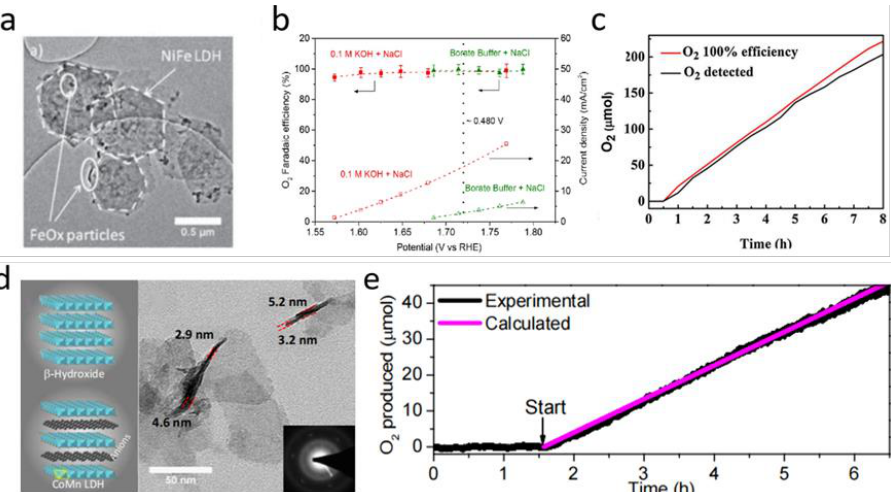
Figure 3. ( a ) TEM image of NiFe LDH nanoparticles [42]. ( b ) O 2 Faradaic efficiency of NiFe LDH nanoparticles in 0.1 M HClO 4 + 3.5 wt% NaCl [42]. ( c ) Faradaic efficiency of Co-Fe LDH catalyst in simulated seawater at a constant overpotential [43]. ( d ) Structure, TEM image, and ( e ) calculated and experimental oxygen production of CoMn LDH nanoplates [45]. Adapted with permission Ref. [42], Copyright 2016, Wiley-VCH. Ref. [43], Copyright 2017, Electrochimica Acta. Ref. [45], Copyright 2014, Journal of the American Chemical Society.